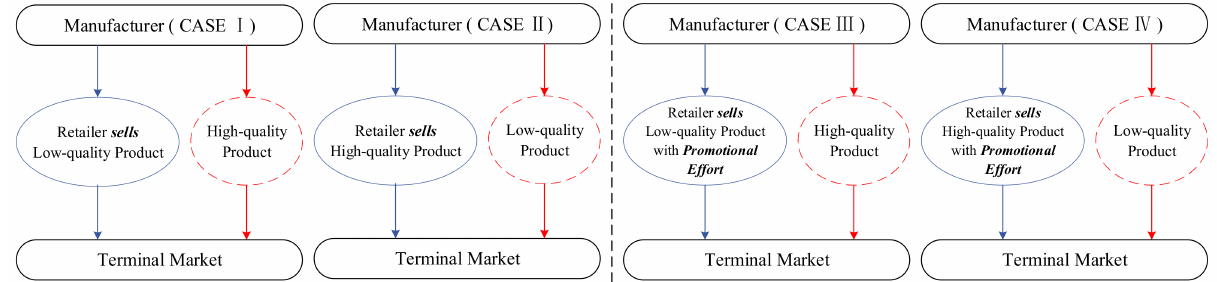
Figure 1. Hybrid-channel supply chain configuration driven by multiple products and promotional